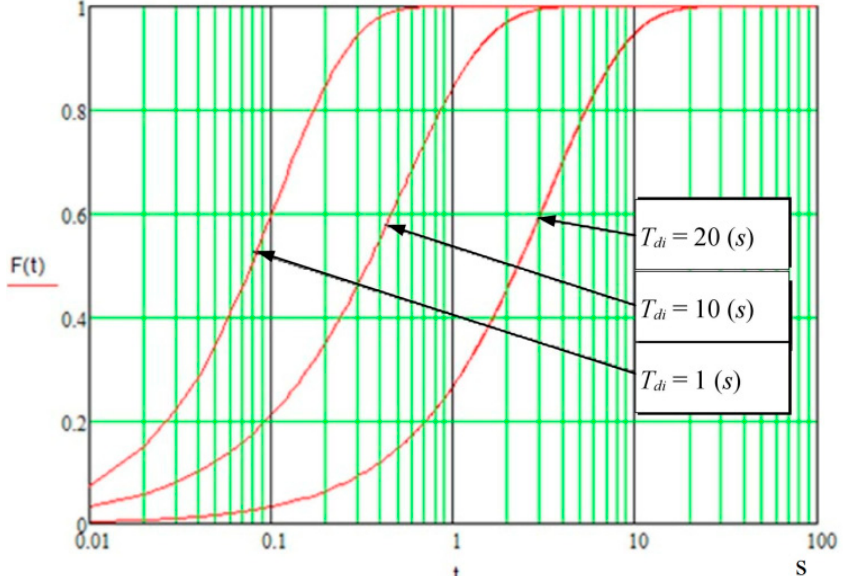
Figure 12. The graph of the distribution functions of successful data delivery in the context of cyberattacks when average time values T di of rehabilitation of functioning of network elements are different.